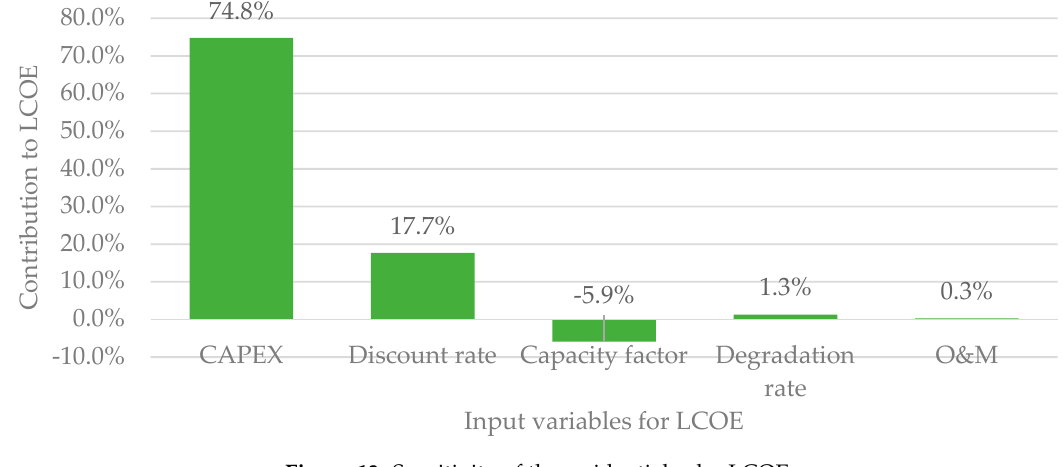
Figure 13. Sensitivity of the residential solar LCOE.